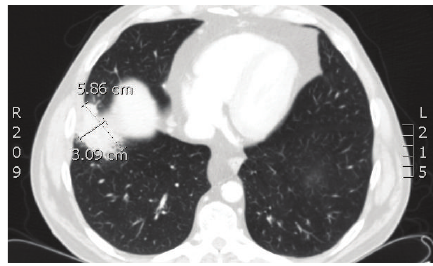
Figure 2: Gallstone-associated subpulmonic fluid collection on preoperative computed tomography measuring 3.09 cm × 5.86 cm.